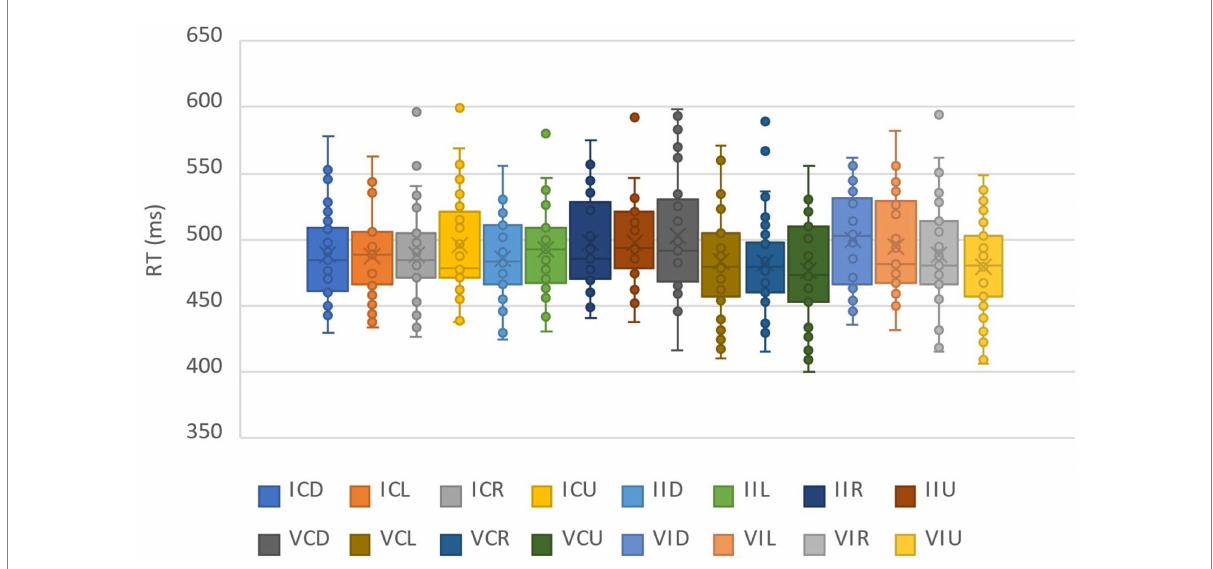
FIGURE 5 The data distribution of all participants under all conditions in Experiment 2. The description of the legend is the same as that of Experiment 1.